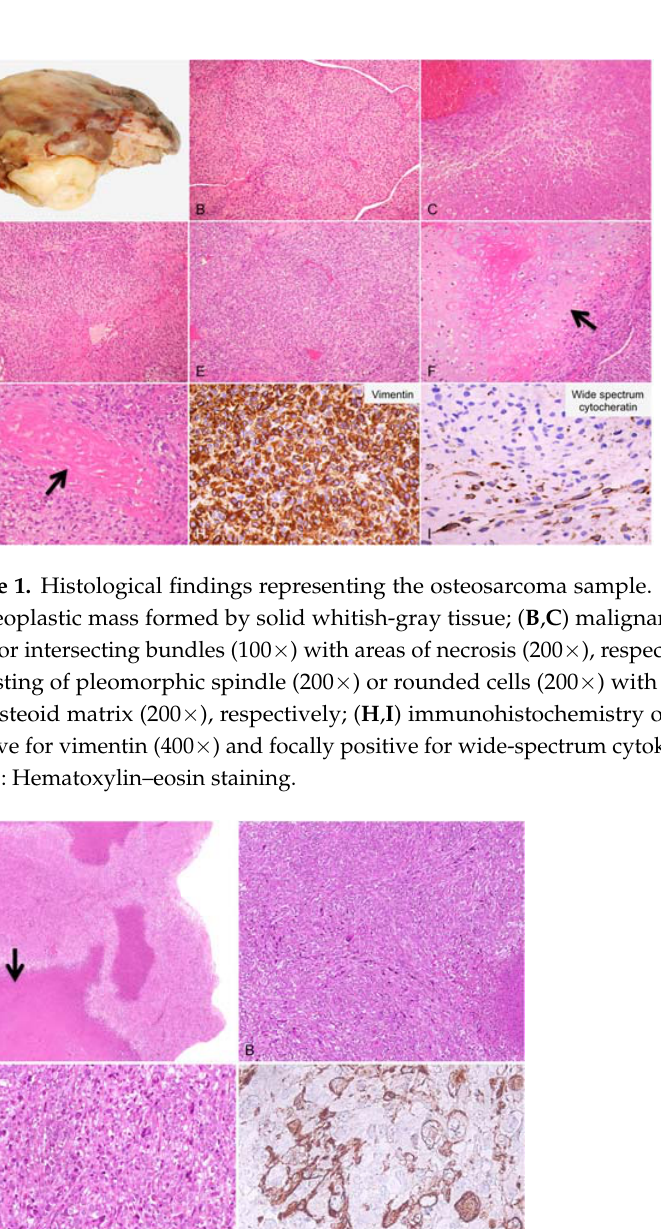
Figure 2. Histological findings representing the leiomyosarcoma case. ( A , B ) Malignant proliferation with extensive areas of necrosis (hematoxylin–eosin, 25×) prevalently made up of spindle cells with thickened chromatin (hematoxylin–eosin, 100×), respectively; ( C ) in delimited areas presence of some multinuclear giant cells and rounded cells with clear cytoplasm (hematoxylin–eosin, 200×); ( D ) immunohistochemistry of neoplastic cells diffusely positive for smooth muscle actin (400×).